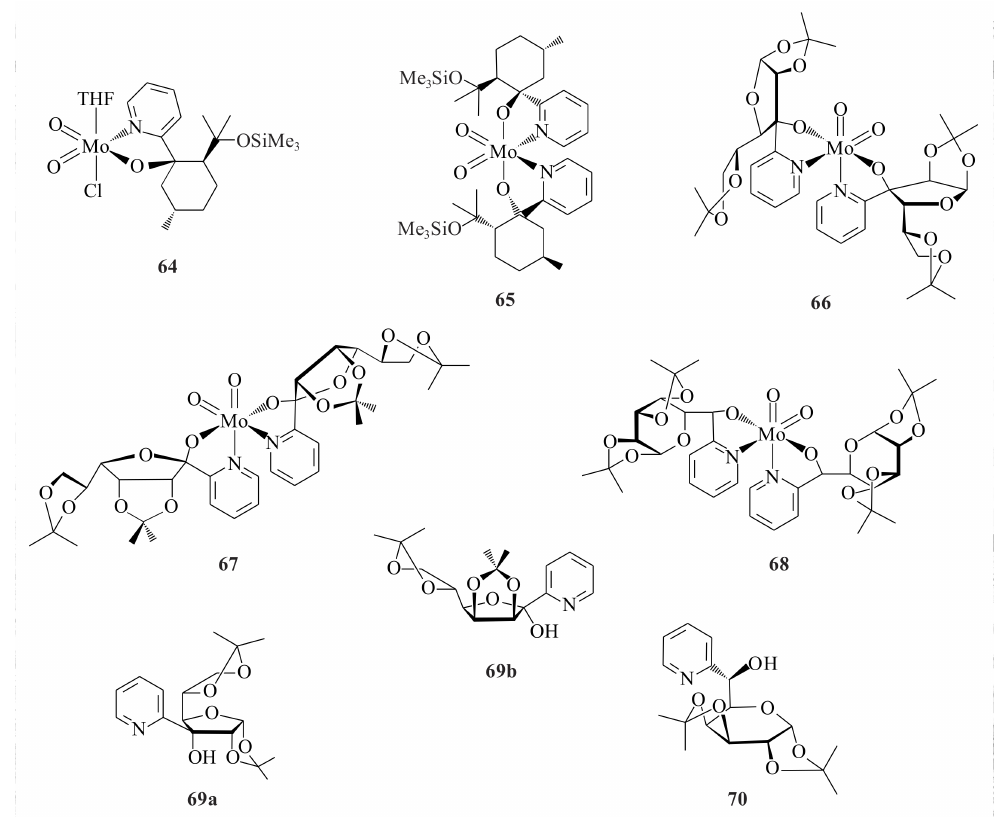
Figure 12. Mo complexes with chiral N , O -ligands. Table 2. Asymmetric epoxidation of trans-methylstyrene with t- BuOOH/CHP and 66 – 68